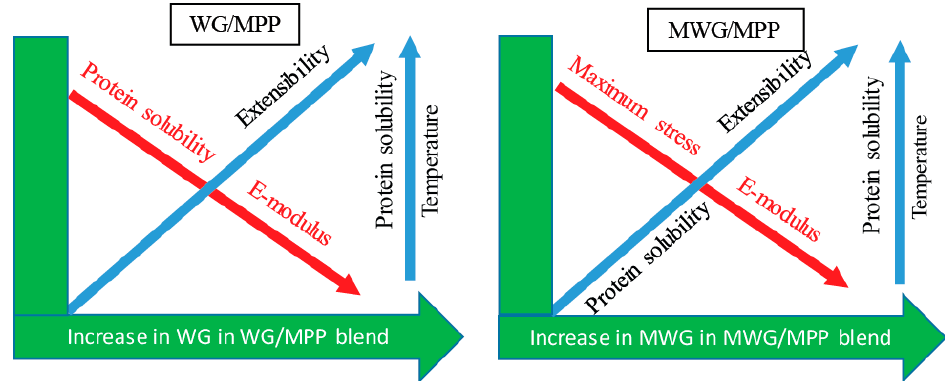
Figure 6. Schematic diagram of summarized effects of temperature and composition of the blend on protein polymerization and mechanical properties.